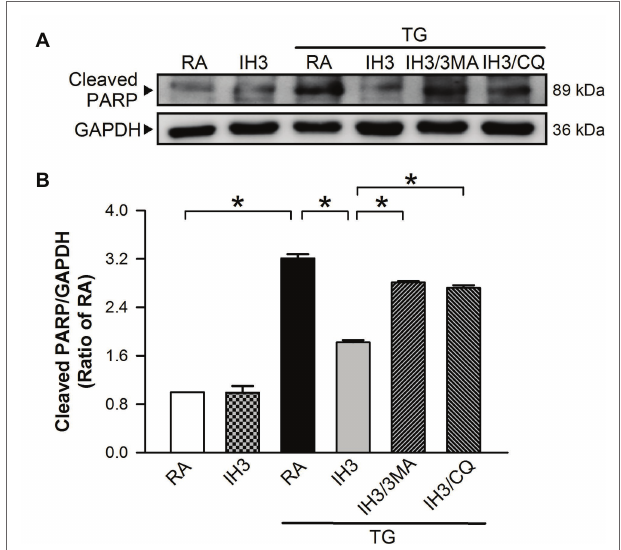
FIGURE 9 | IH-induced myocardial autophagy contributes to the attenuation of ER stress-induced myocardial apoptosis in vivo . C57BL/6 mice were exposed to RA or IH for 3 days followed by thapsigargin (5 mg/kg/day) alone, thapsigargin combined with 3-methyladenine (15 mg/kg/day), or methyladenine combined with chloroquine (20 mg/kg/day), and then sacrificed for detecting the myocardial cleaved PARP and GAPDH protein levels. (A) A representative result of cleaved PARP and GAPDH protein levels determined by Western blot analyses. (B) Quantitative results of cleaved PARP protein levels were adjusted with GAPDH protein level and expressed as ratio over the RA control group. Values are means ± SEMs. ( n = 3). * p < 0.05. MA, 3-methyladenine; CQ, chloroquine; IH, intermittent hypoxia; RA, room air; TG,